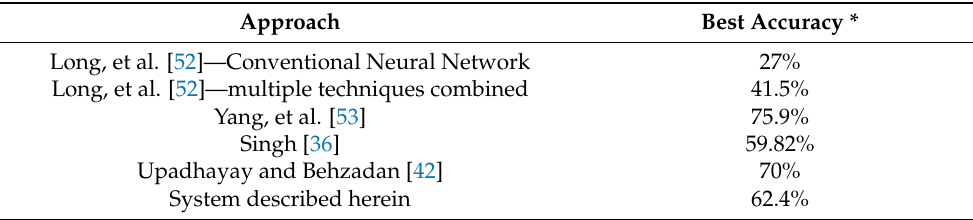
Table 5. Comparison of Different Prior